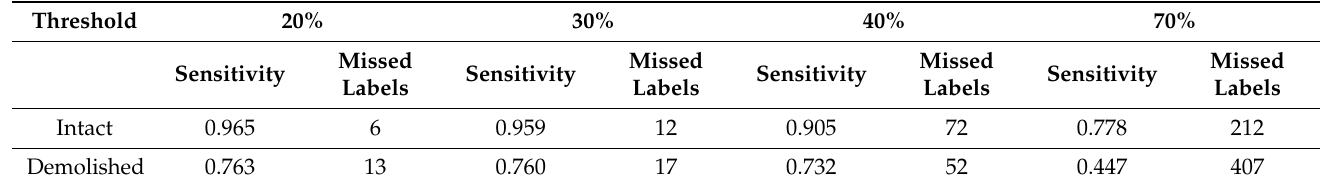
Table 3. Effect of areal percentage thresholds on the network’s